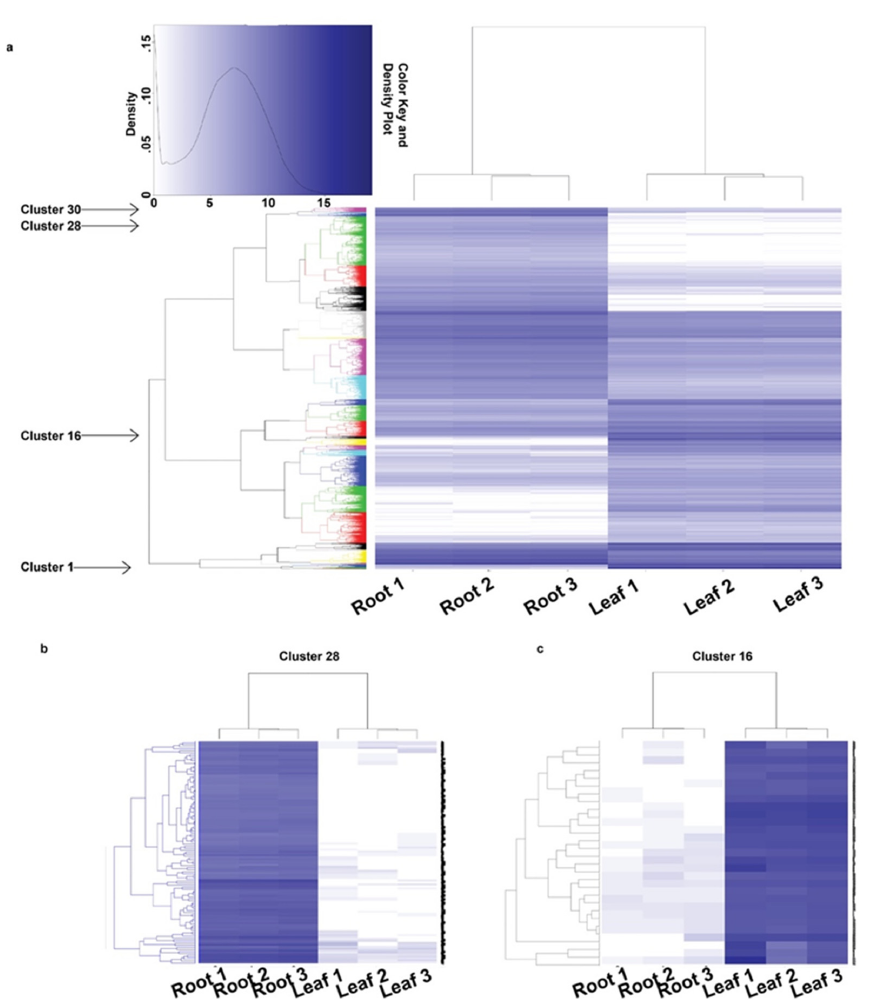
Figure 4. Hierarchical clustering and expression patterns of differentially expressed contigs (DECs) in root and leaf tissues. ( a ) Hierarchical clustering of the DECs into 30 clusters; ( b ) magnification of cluster 28; ( c ) magnification of cluster 16. Root 1,2,3 represent the three root biological replicates used in the analysis and Leaf 1,2,3 represent the three leaf biological replicates used in the analysis. Each horizontal line represents a contig among the 14,267 contigs showing significant difference (fold change >= 2; FDR < 0.01) in expression. Colors depict expression levels, with darker colors corresponding to higher expression.